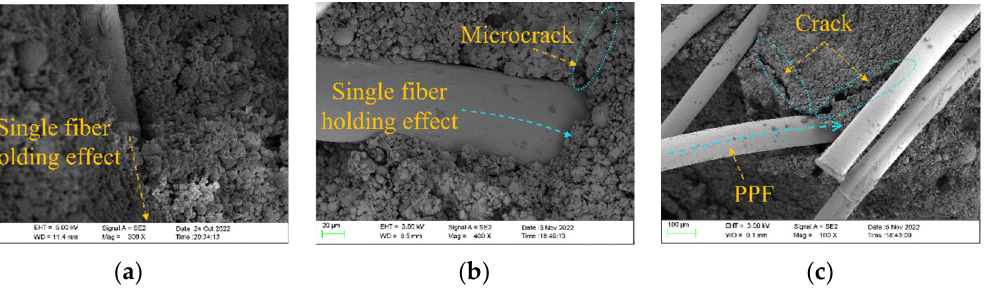
Figure 17. Mechanism diagram of fiber action inside the sample. ( a ) Gripping effect. ( b ) Gripping effect. ( c ) Inhibition of fission development. effect. ( c ) Inhibition of fission